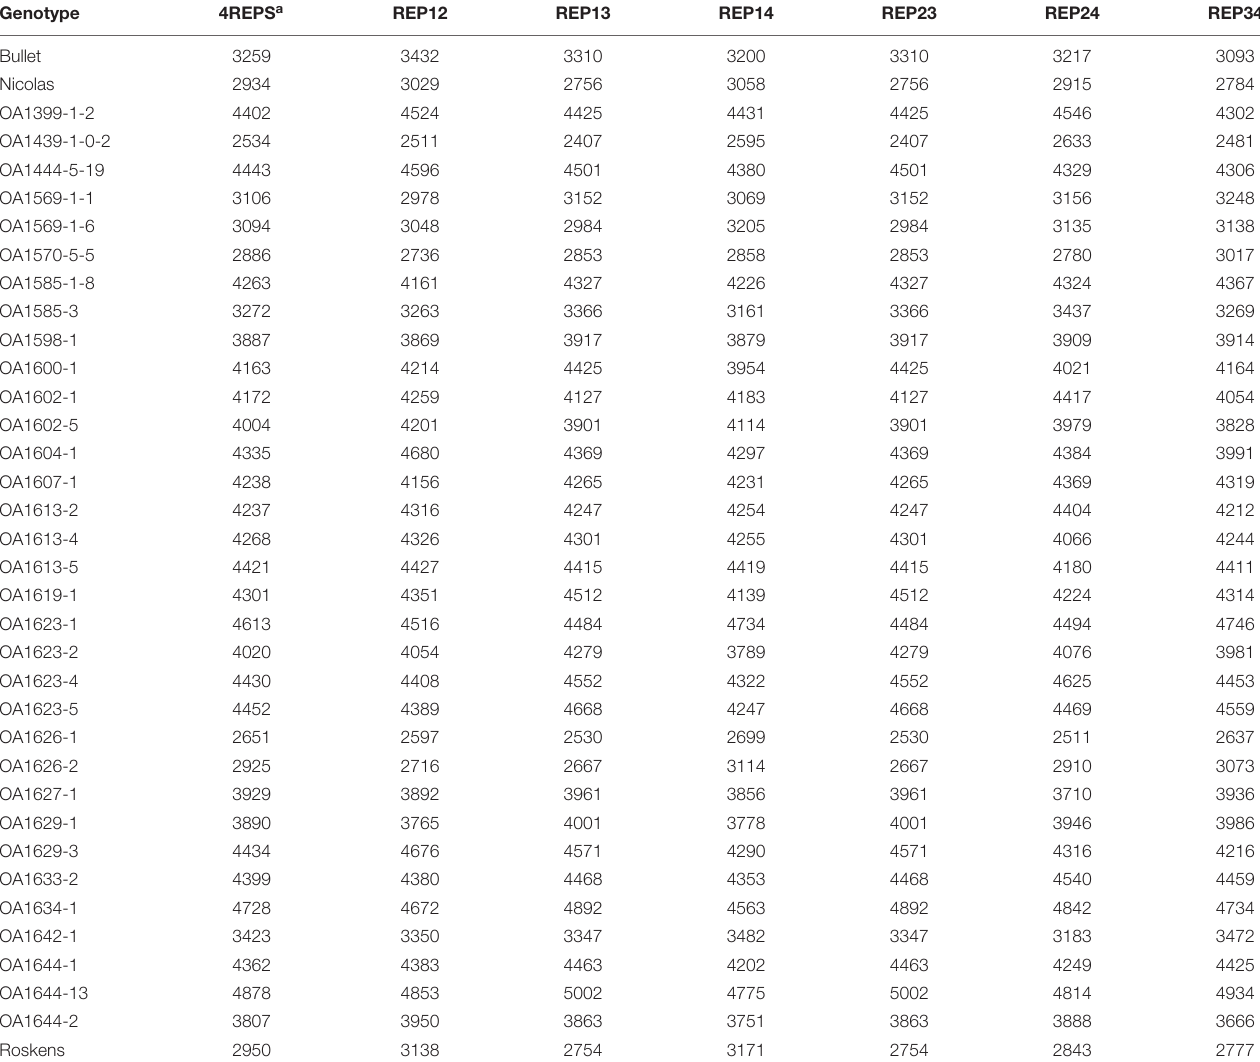
TABLE 4 | Mean yield (kg ha − 1 ) across locations based on all or any two of the four replicates for the 2019 Ontario test.